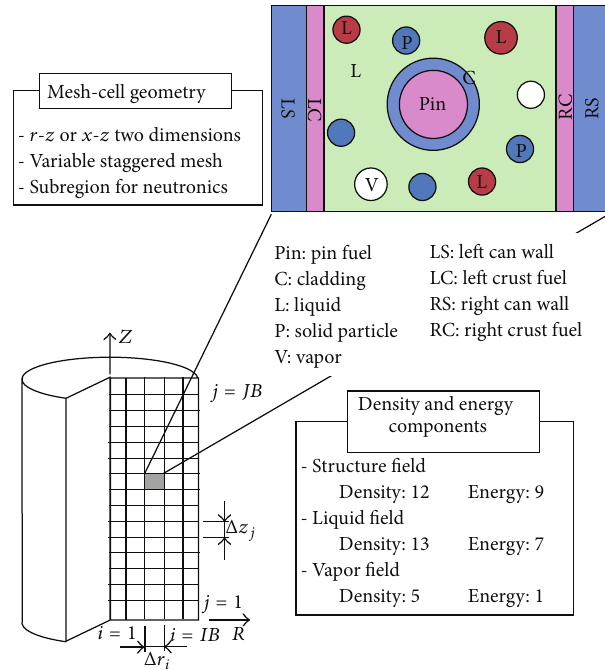
Figure 3: SIMMER-III geometric framework.